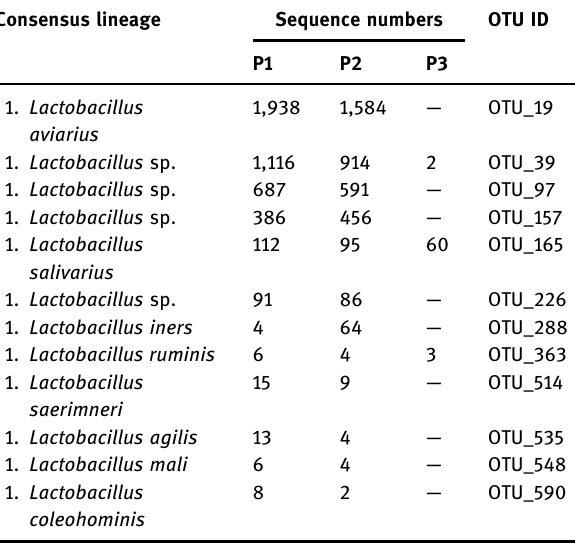
Table 1: Bacterial species identi fi ed from rearing water of com - mercial shrimp ponds on the day of culture ( DOC )